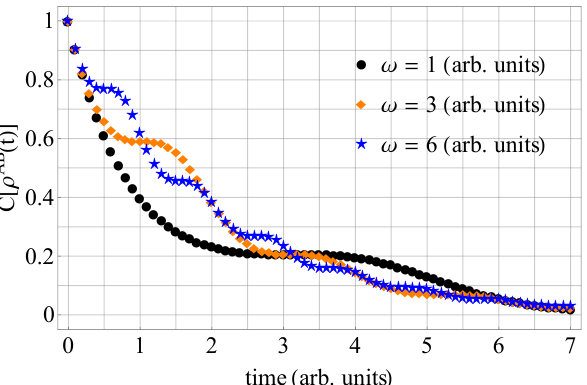
Figure 4. Plots present the probability of finding a two-qubit system in one of the possible states. The initial state is represented by (19).